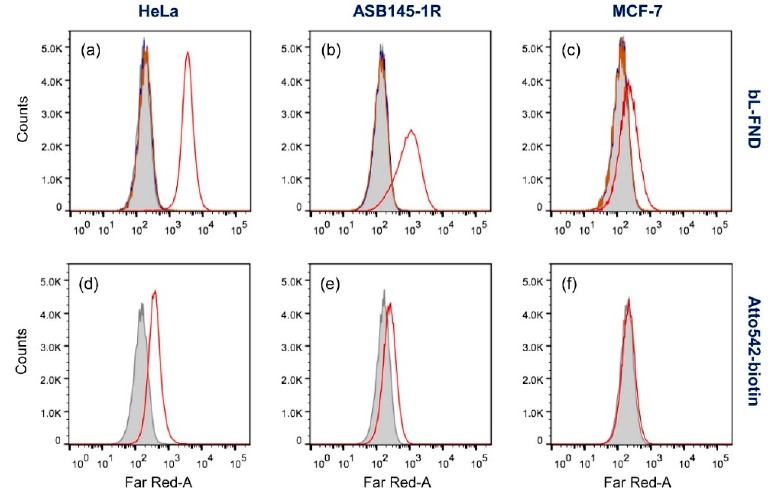
Figure 3. Flow cytometric analysis of HeLa ( a , d ), ASB145-1R ( b , e ), and MCF-7 ( c , f ) cells labeled with biotin-anti-CD44 antibody, NeutrAvidin, and bL-FND (a–c) or Atto542-biotin (d–f), respectively. Control experiments were performed following the same labeling procedures, but without NeutrAvidin (blue) or biotin-anti-CD44 antibody (orange). Cell-only results are given in grey. We further examined the effect of particle size on the cell labeling efficiency by flow cytometry.